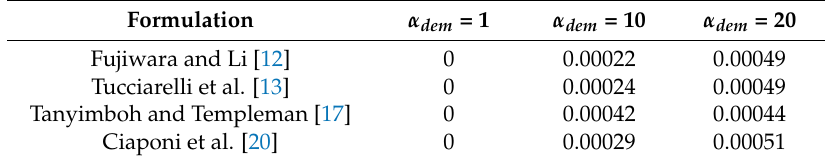
Table 1. First case study. Mean absolute deviation (m 3 /s) of the various formulations in terms of outflow q to users compared to the Wagner et al. [9] formulation for the three values of α dem .